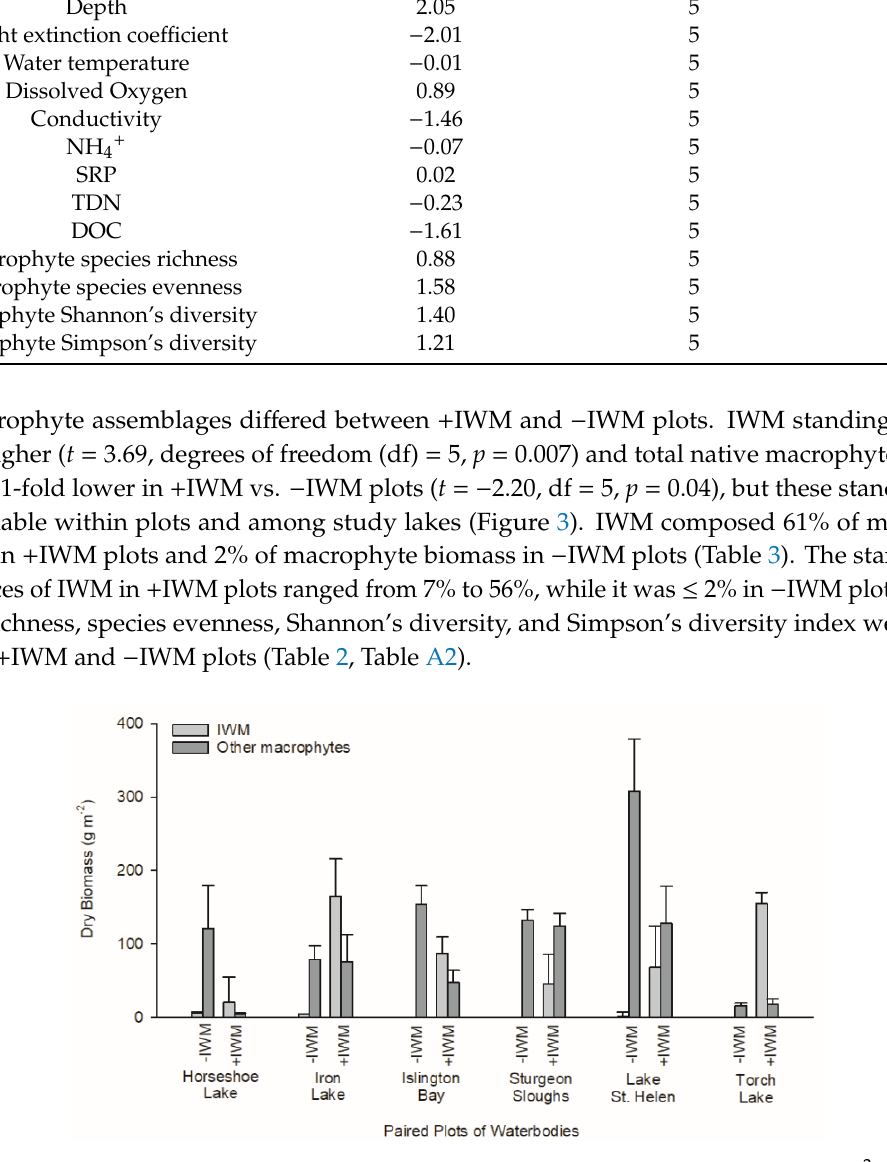
Figure 3. Standing crops of macrophytes in paired + IWM and − IWM plots, scaled per m 2 of plot surface area. “Other macrophytes” represents the sum of mean standing crops of all native macrophyte species in each plot. An error bar represents the standard error of 20 samples collected in each plot.